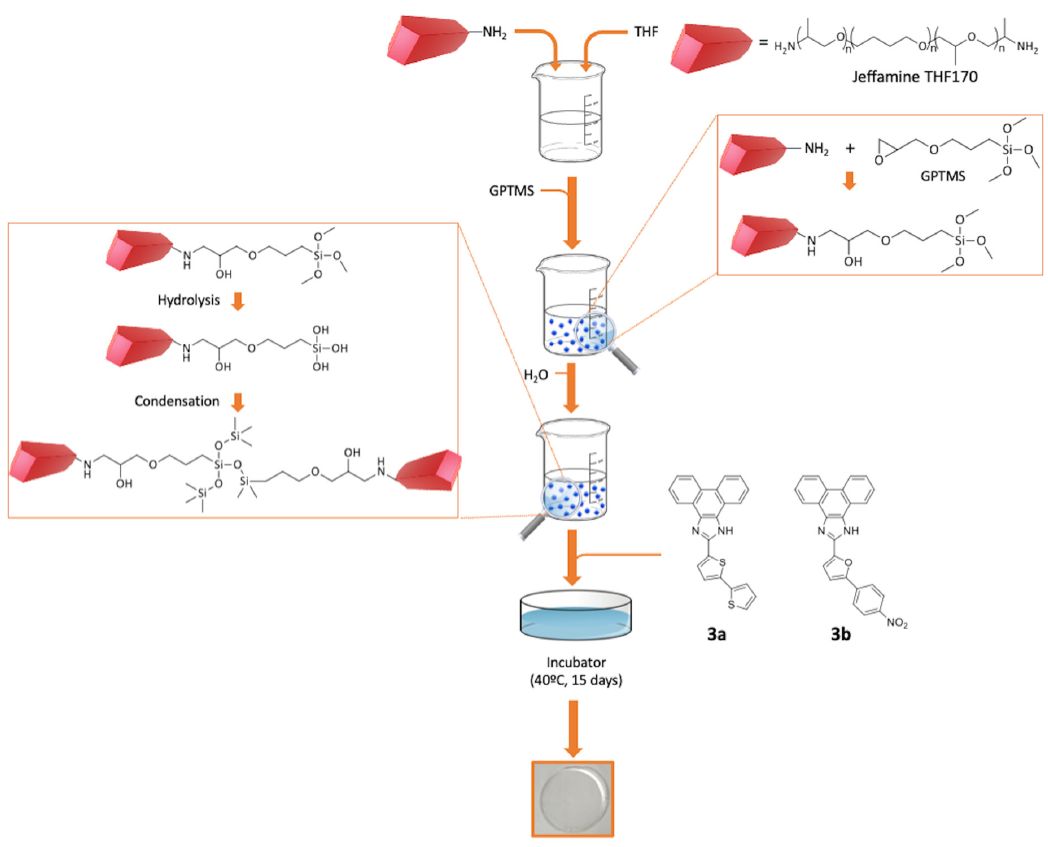
Figure 2. Synthesis of the OIH sol–gel matrices.